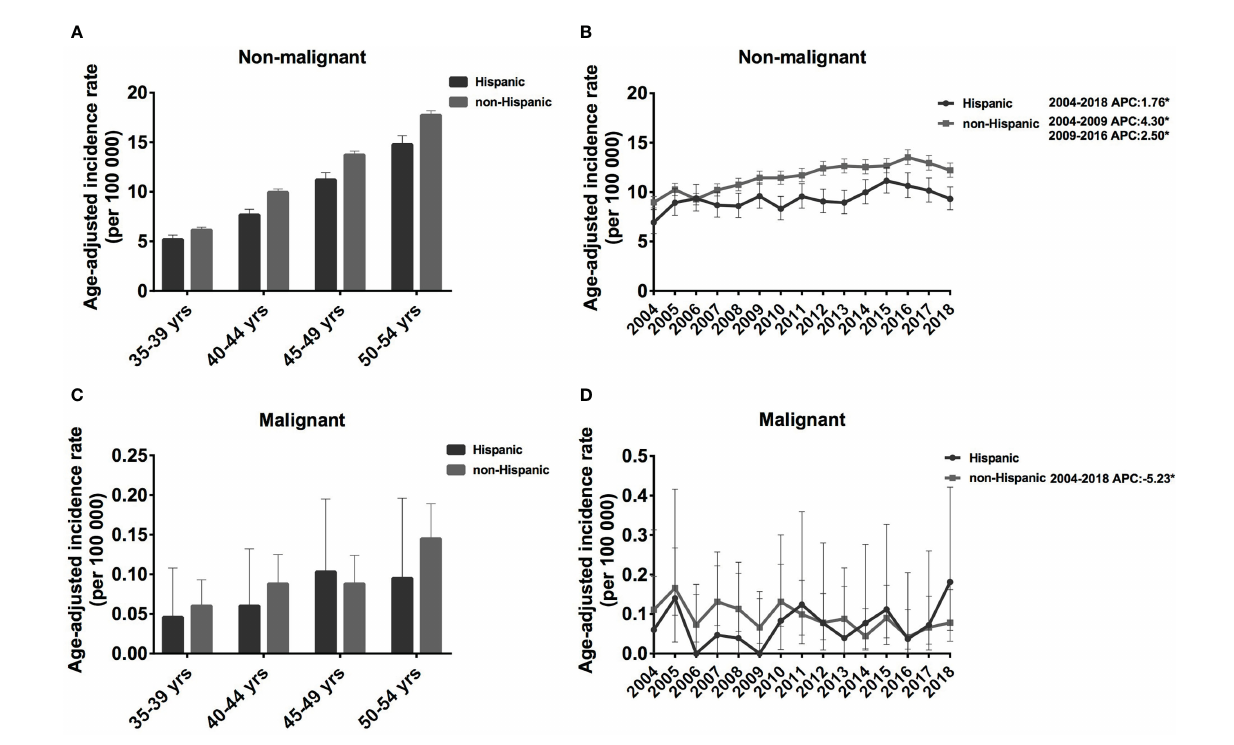
FIGURE 3 Age-adjusted incidence rates (IRs) and annual percent changes (APCs) by age and ethnicity. IRs by ethnicity and by 5-year age intervals (A, C) , APCs by ethnicity over time from 2004 – 2018 (B, D) . (A, B) , non-malignant meningioma; (C, D) , malignant meningioma. *Only show APCs that are signi fi cantly different at the P < 0.05